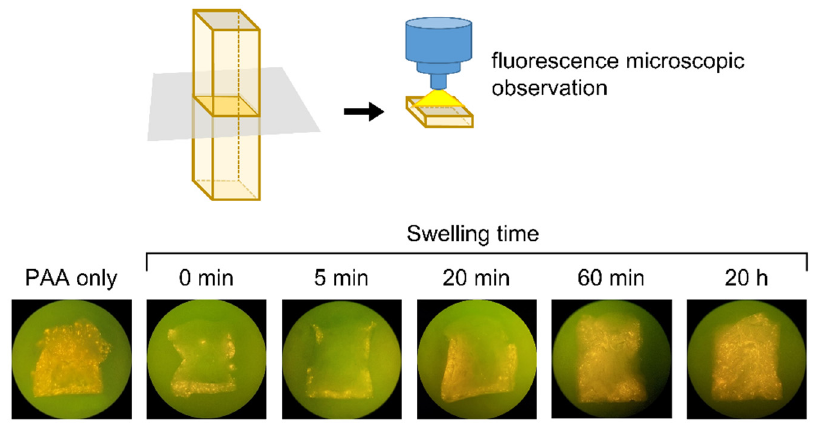
Figure 1. Fluorescence microscopic images of cross-section of the PAA/PVP complexes. When the porous PAA/PVP complex sponge came into contact with water, it rapidly swelled to form a bioadhesive hydrogel, indicating its ability to adhere to bio-tissues in a considerably short contact time. The shear adhesion strength of the PAA/PVP complex sponges with a synthetic leather piece after contact for 1–30 s was evaluated and compared with that of PAA/PVP complex films. A PAA/PVP complex sponge sheet was prepared with a swelling time of 60 min. The PAA/PVP complex film or sponge was kept in contact with the leather for 1–30 s without pressing, and the force required to detach the complex from leather was measured. The complex of the porous sponge form immediately swelled and adhered to the wetted leather piece with adhesion strength of 0.36 N/cm 2 within 1 s. The force required for detachment gradually increased with increasing contacting time up to 0.9 N/cm 2 at 20 s and decreased thereafter (Figure 2). In contrast, the film of the PAA/PVP complex showed lower adhesion strength than the sponge at a short contact time (10 s or less). It also increased with time and was higher than that of the sponge sheet after 30 s of contact.